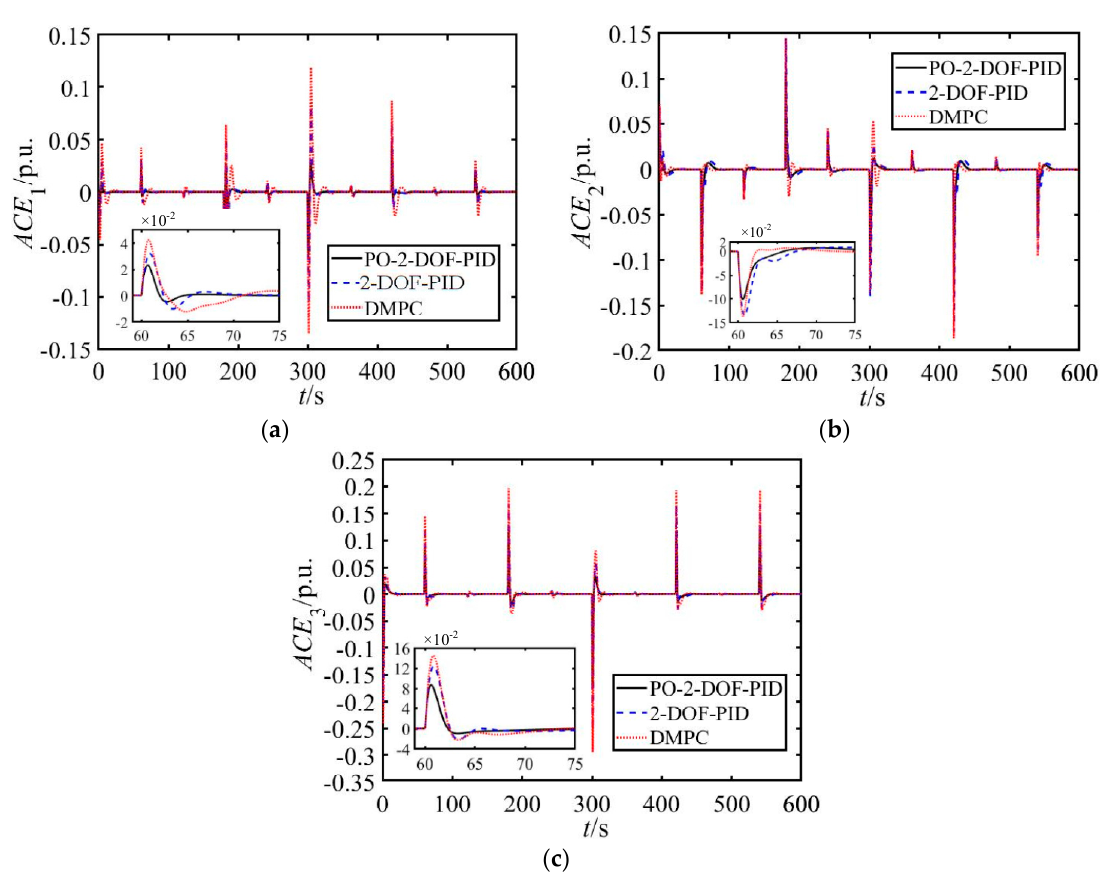
Figure 11. ACE of power system under low wind speed. ( a ) Area1 ( b ) Area2. ( c ) Area3.